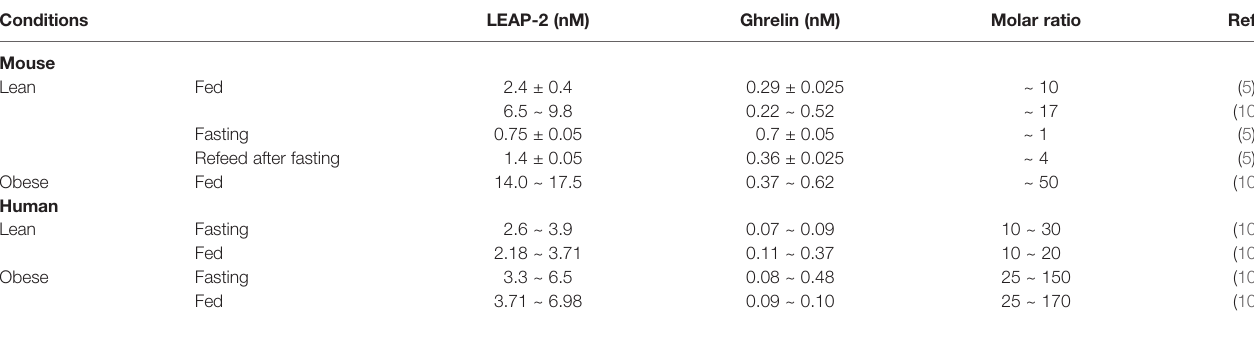
TABLE 3 | LEAP-2 and ghrelin levels in positive or negative energy balance.